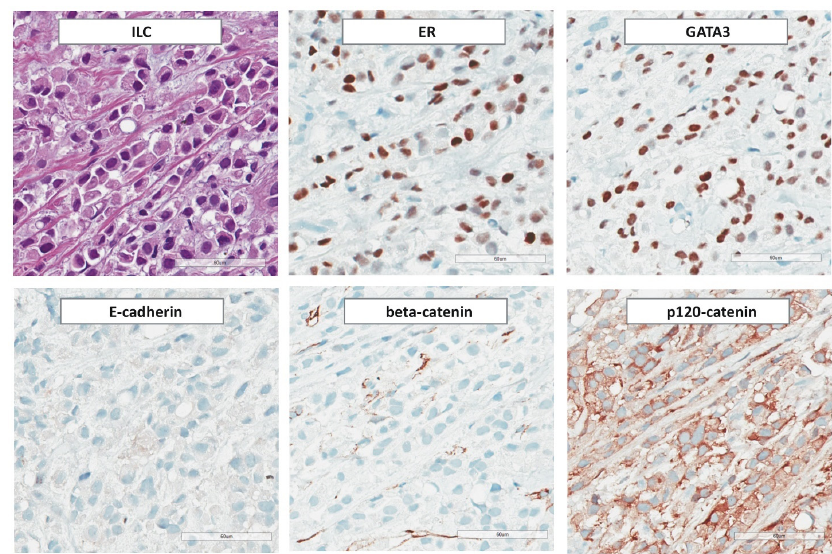
Figure 3. Immunohistochemical features of ILC. From Photomicrographs (×200 magnification) illustrate: expression of ER and GATA3, loss of E-cadherin and β -catenin, and aberrant cytoplasmic localization of p120-catenin.